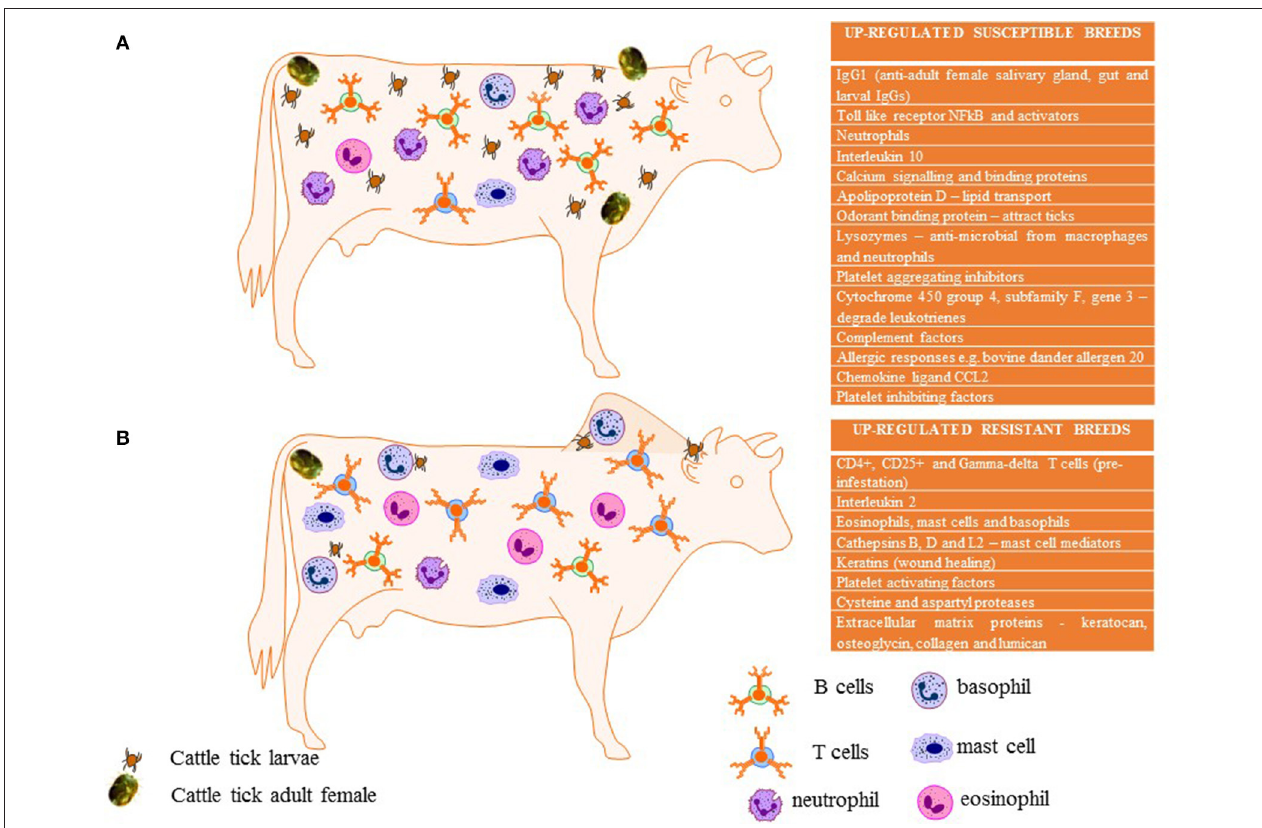
FIGURE 1 | Summary of expression and immunological profiles commonly associated in tick susceptible (A) compared to tick resistant breeds (B) of cattle as identified in Table 1 . This diagram was created using images from Motifolio